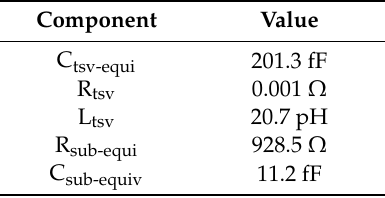
Table 1. Lumped circuit elements of TSV–TSV noise coupling.